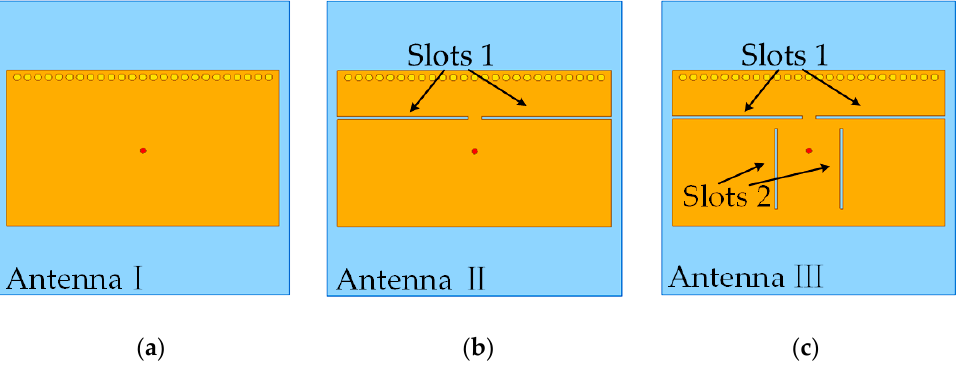
Figure 2. Design process of the proposed antenna: ( a ) Antenna I: traditional PIFA; ( b ) Antenna II: PIFA with Slots 1; ( c ) Antenna III: PIFA with Slots 1 and Slots 2.